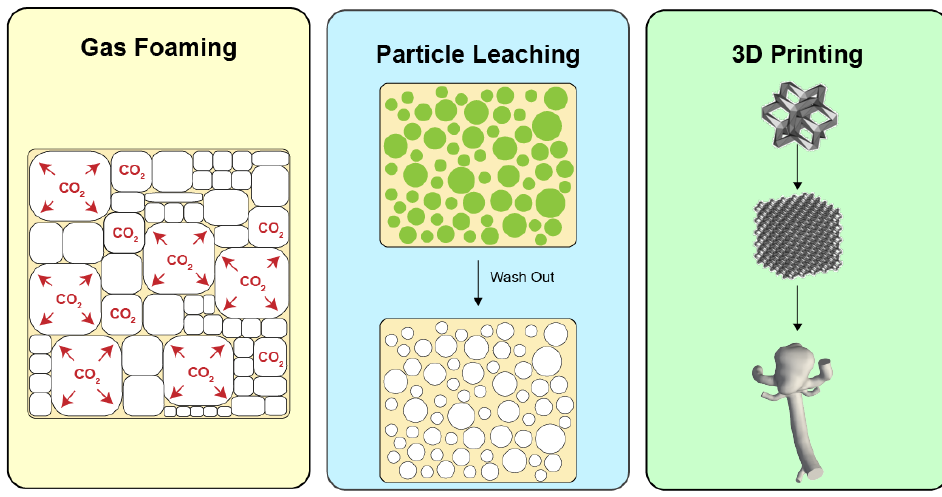
Figure 5. Methods for the fabrication of porous SMPs: CO 2 gas foaming ( left ), particle leaching ( middle ), and 3D printing ( right